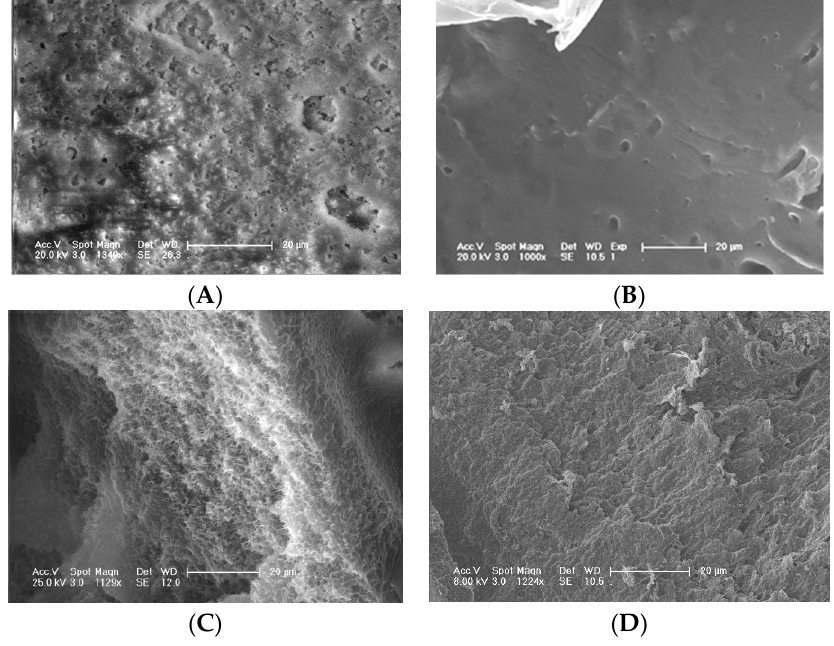
Figure 2. SEM images of pore surface and wall of S PI ( A , C ) and S MM ( B , D ). The bar length is 20 μ m.